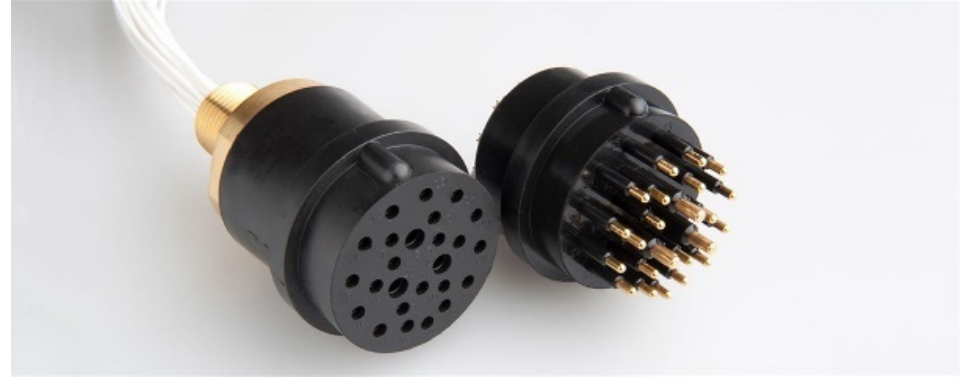
Figure 3. The SubConn® Circular Series [24].